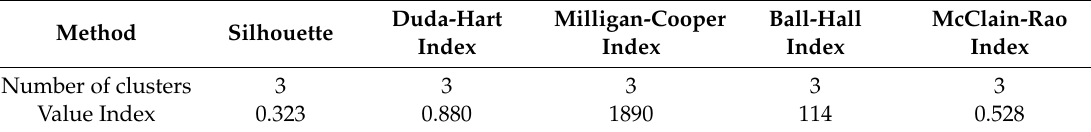
Table 3. Optimal number of